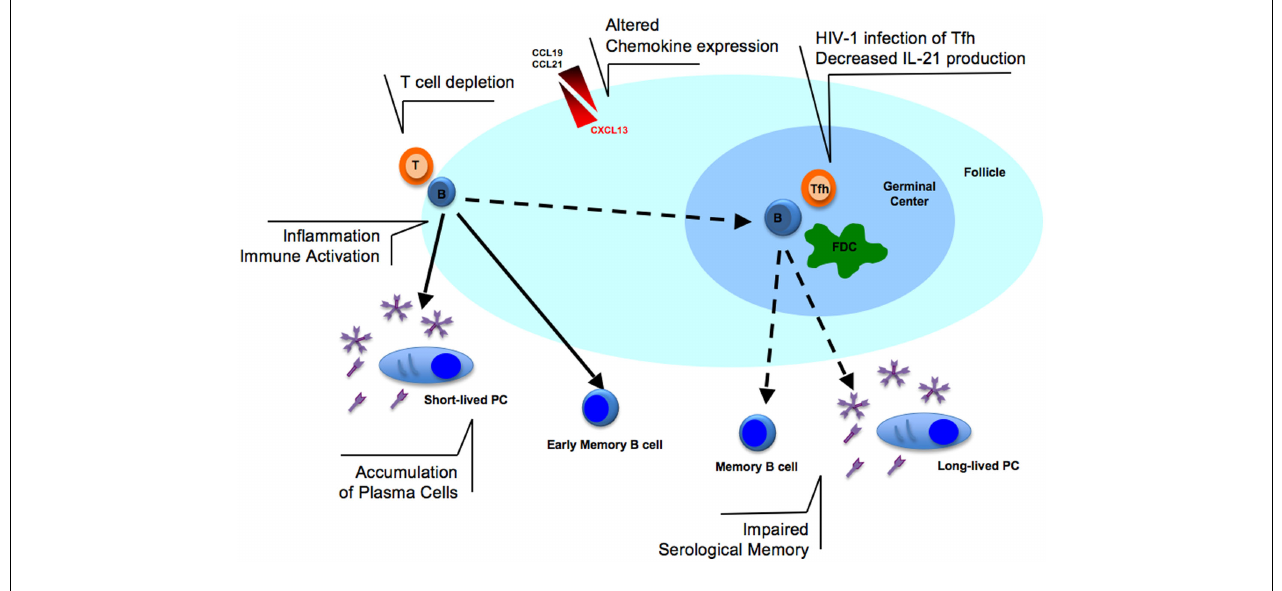
also reduced during HIV-1 infection.The consequence of these dysfunctions may ultimately result in the impaired serological memory observed in HIV-1 infected patients. In addition, immune activation and inflammation, pathogenic features of HIV-1 infection, may contribute to B cell polyclonal activation and accumulation of plasma cells in lymphoid tissues possibly contributing to hypergammaglobulinemia found in serum of infected